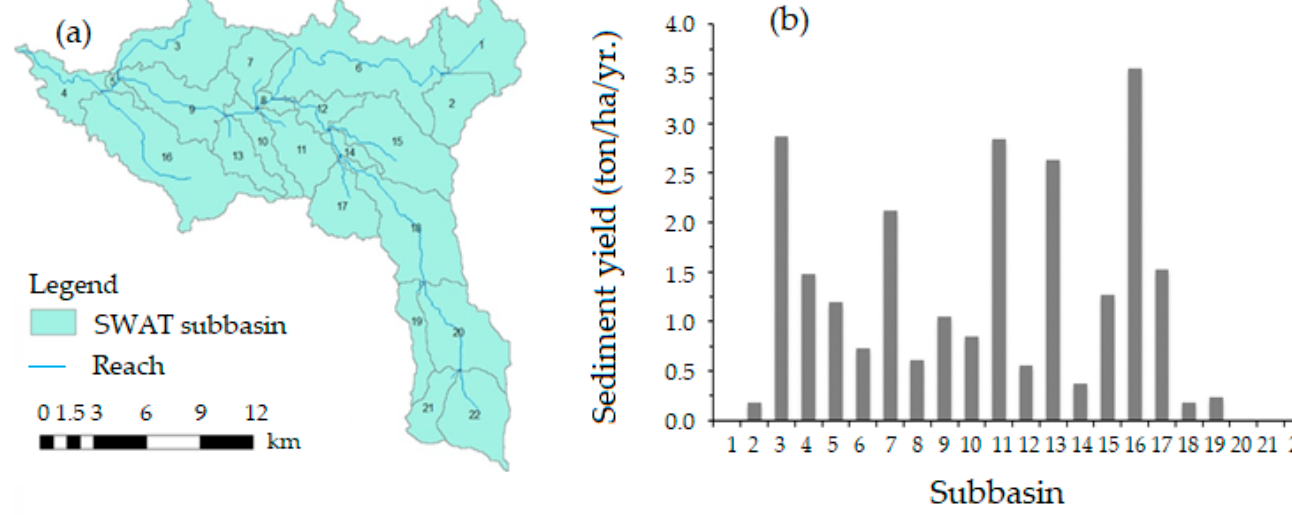
Figure 7. SWAT classified subbasins for prioritization ( a ) and SWAT simulated annual sediment yield in Koga subbasins ( b ).